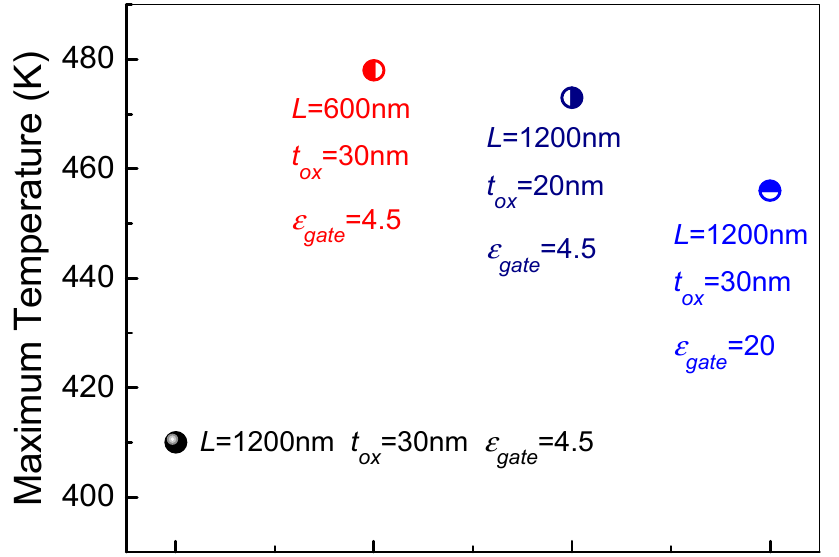
Figure 11. Drain currents as functions of drain voltages for different parameter configurations.